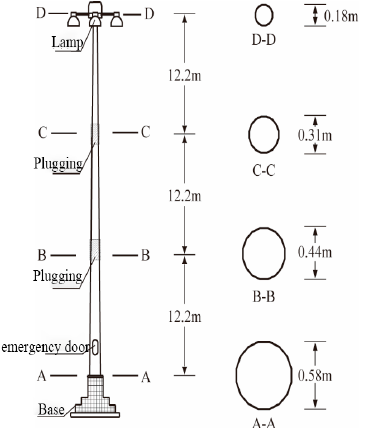
Figure 4. Structural schematic diagram.